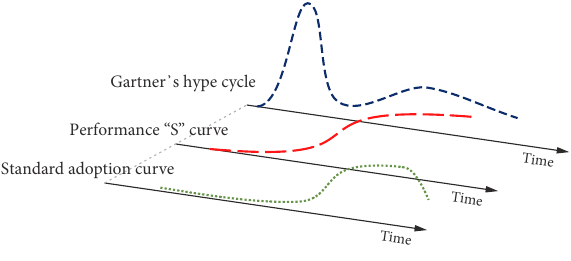
T i m e T i m e T i m e